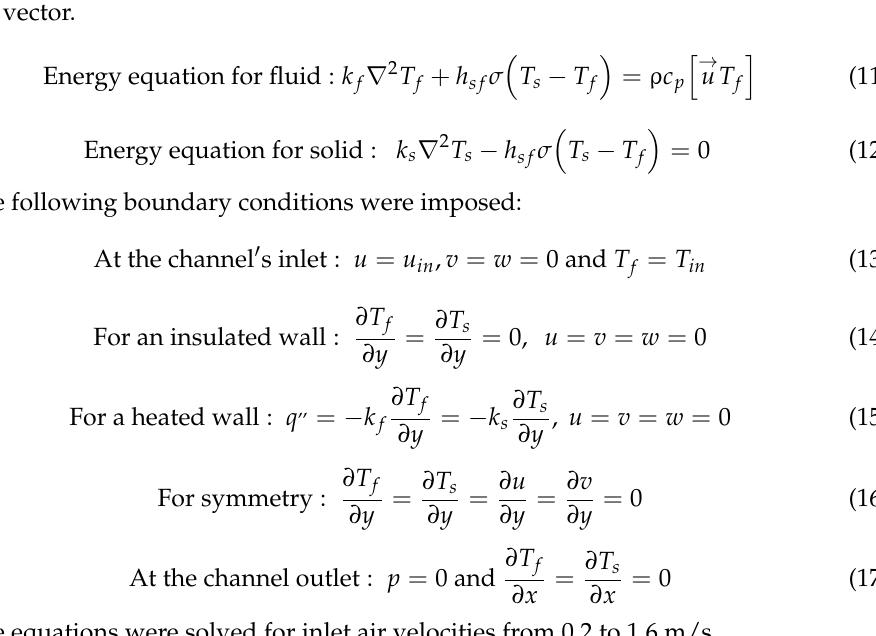
Figure 1. Solution domain for preliminary study.